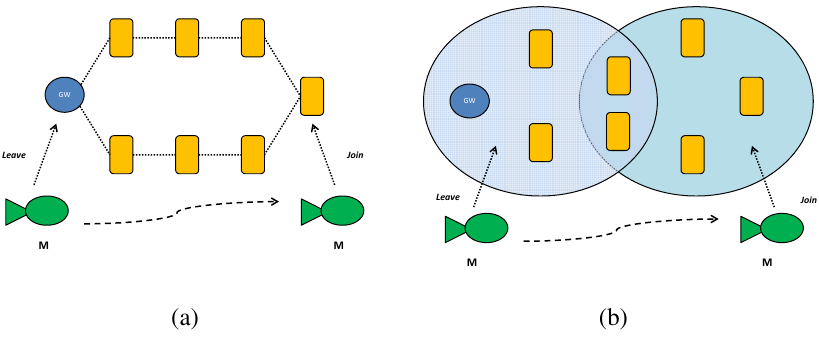
Figure 12. ( a ) Sparse Scenario; ( b ) Dense